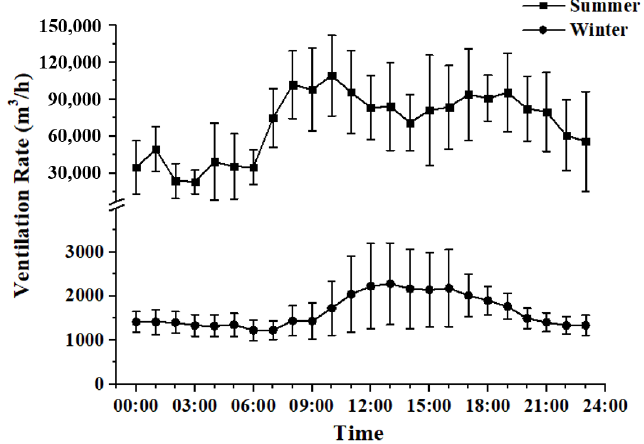
Figure 4. Diurnal variation of ventilation rate in pig house.